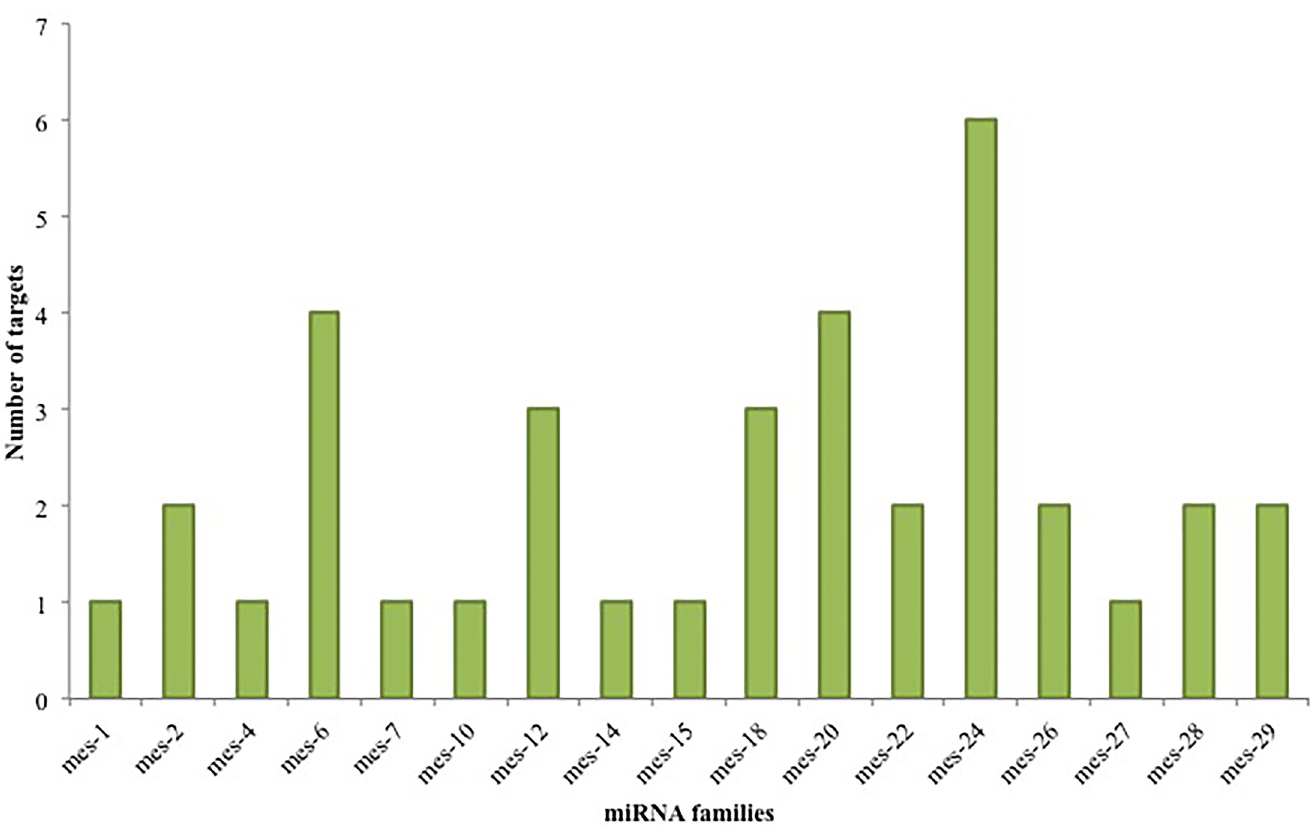
Fig 10. The number of targets predicted for the novel miRNA families identified in